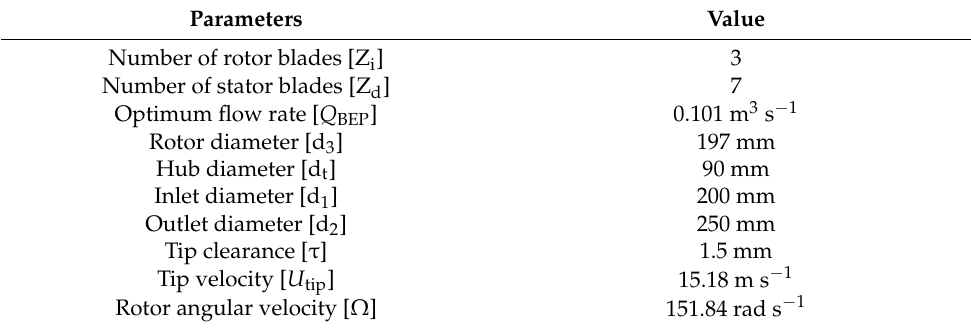
Table 1. Pump geometry and reference